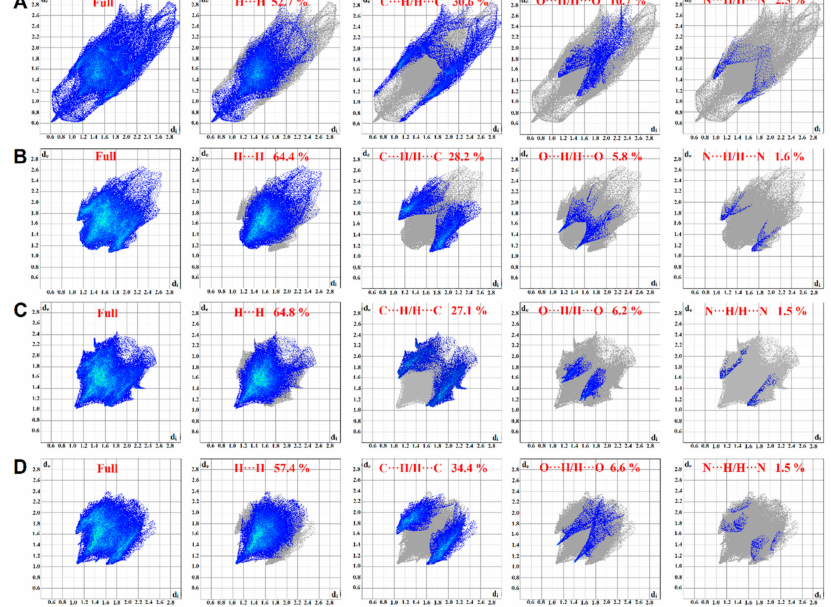
Figure 9. The 2D fingerprint plots for compounds 1 ( A ), 2 ( B ), 3 ( C ) and 4 ( D ).